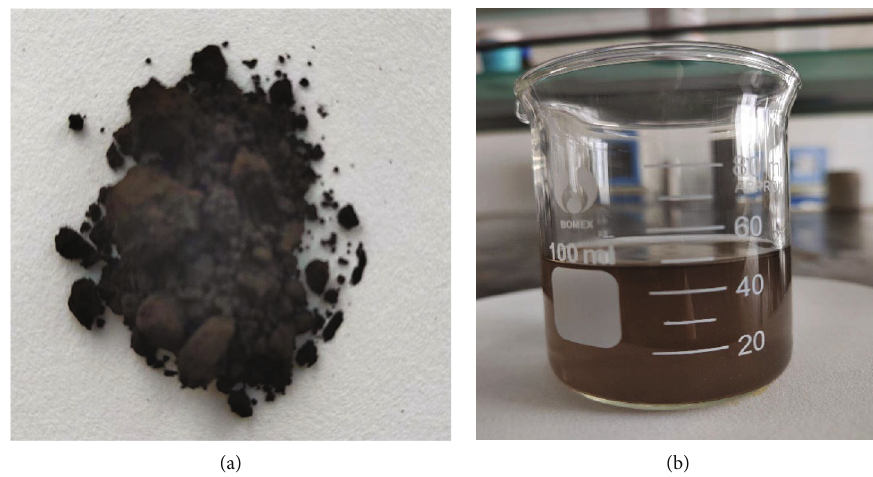
Figure 1: The photograph of GO: (a) GO powder; (b) GO solution dissolved in acetone (The concentration of 0.1%).